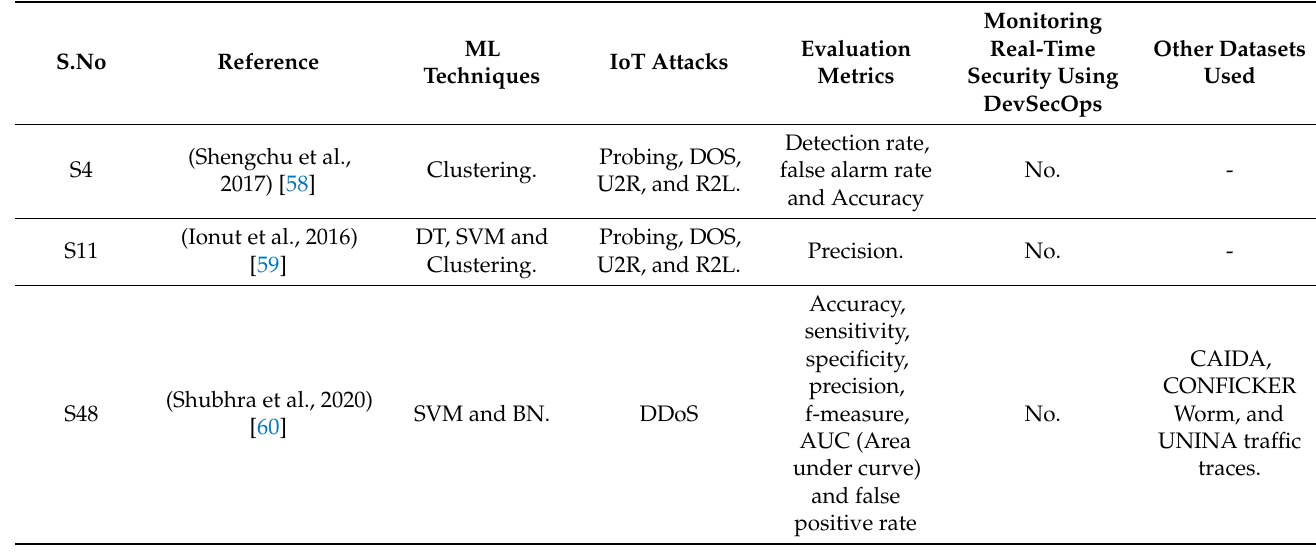
Table 6. KDDCUP99 dataset.